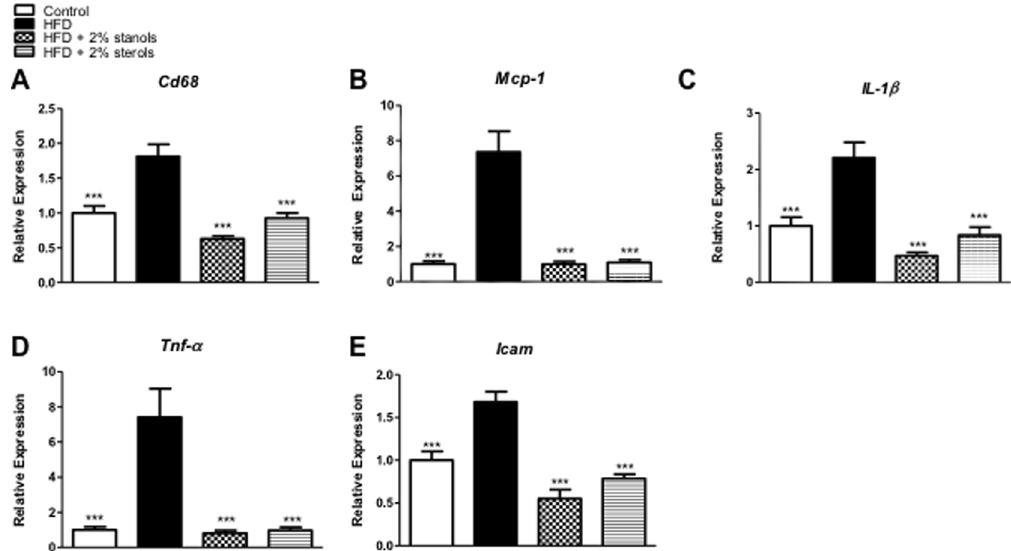
Figure 2. Hepatic gene expression. (A–E) Gene expression analysis of the macrophage marker Cd68 , monocyte chemoattractant protein 1 ( Mcp- 1 ), interleukin 1 b ( IL-1 b ), tumor necrosis factor a ( Tnf- a ) and intercellular adhesion molecule 1 ( Icam ). Relative expression was normalized to endogenous control gene Cyclophilin A. Data were set relative to group on chow diet. n=10 per group. *P , 0.05, **P , 0.01, and ***P , 0.001, respectively.